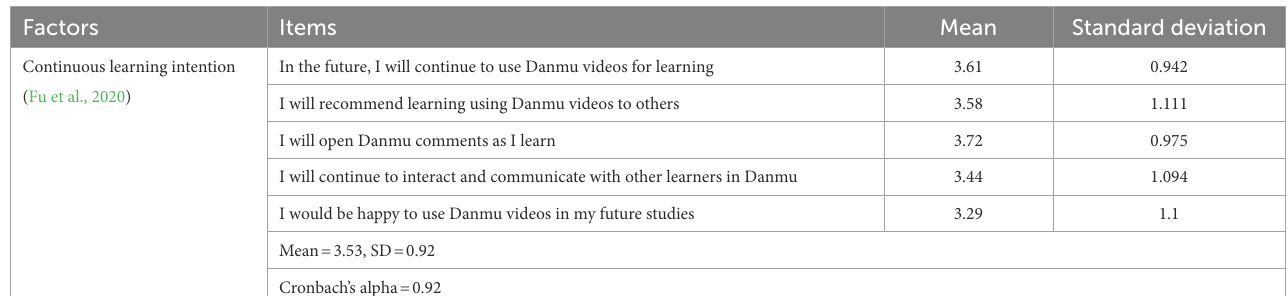
TABLE 4 Continuous learning intention.